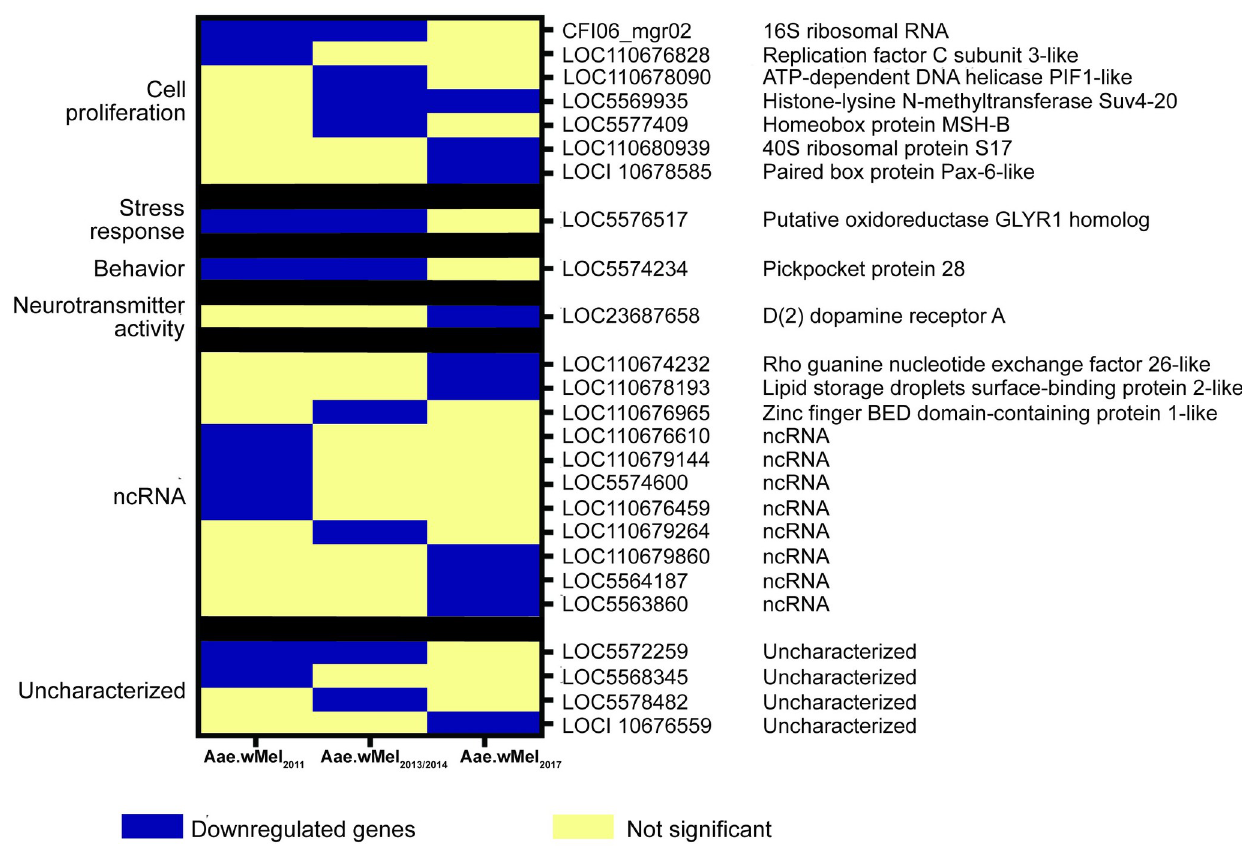
Fig 6. Topmost downregulated genes with highest fold difference between Wolbachia -infected and uninfected Aedes aegypti , according to release year. The type of downregulated gene (cell proliferation, stress response, behaviour, neurotransmitter activity, ncRNA, and uncharacterised) is shown.